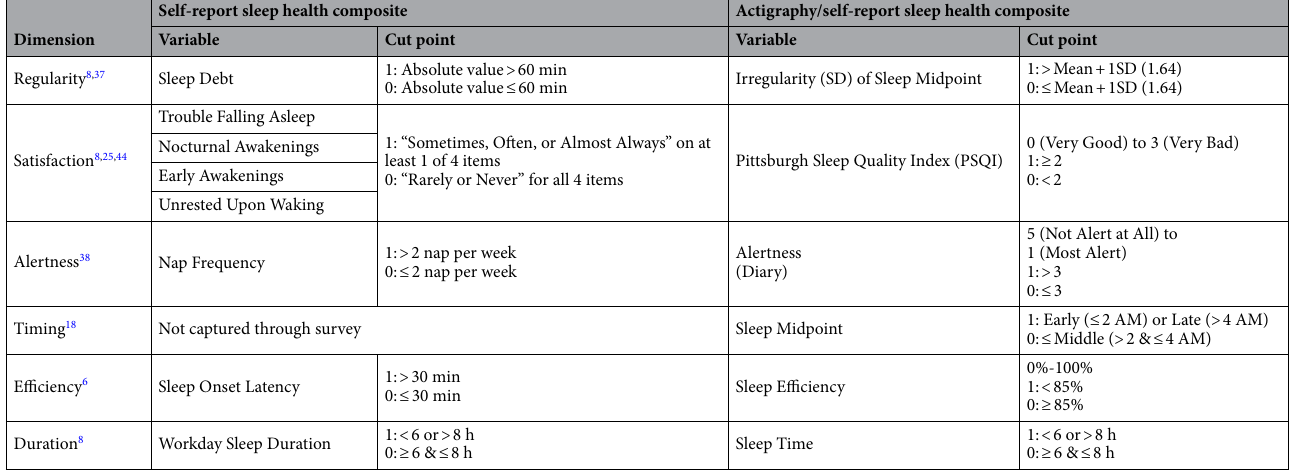
v9.4 procedure GENMOD to test the associations of each sleep health composite with the risk of heart disease. This method allows for estimation of relative risks ( RR ; adjusted relative risks: a RR ) and is recommended when the prevalence of outcome is > 10% 42,43 . The self-report only and actigraphy/self-report sleep health composites were included in separate models. To test differences by sex (men vs. women) and race (non-Hispanic Black, all other races, vs. non-Hispanic White), we used chi-squared tests, t -tests, and interaction terms between sleep health composites and each of sex and race in separate models. Continuous covariates were z-scored to improve interpretability in relation to each sleep health composite (i.e., weighted sum of z-scores). Significance was deter- mined by using two-tailed test with a p -value of <.05.